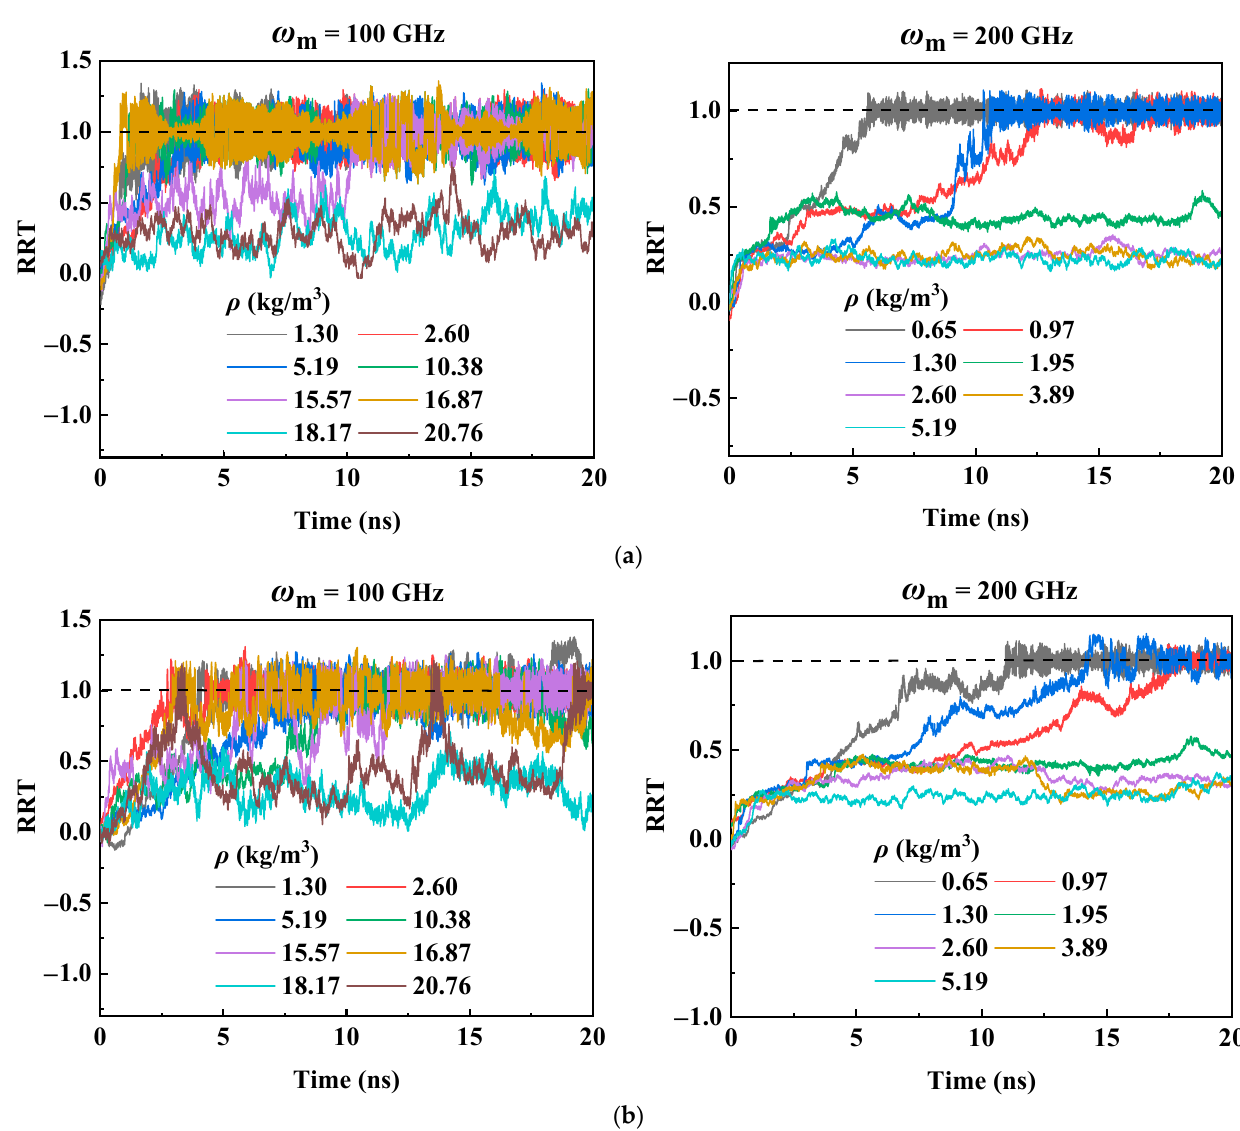
Figure 5. Time histories of the RRT curves for RTS under the cases of different simulation box sizes: ( a ) 16 nm × 16 nm × 8 nm, and ( b ) 32 nm × 32 nm × 8 nm.